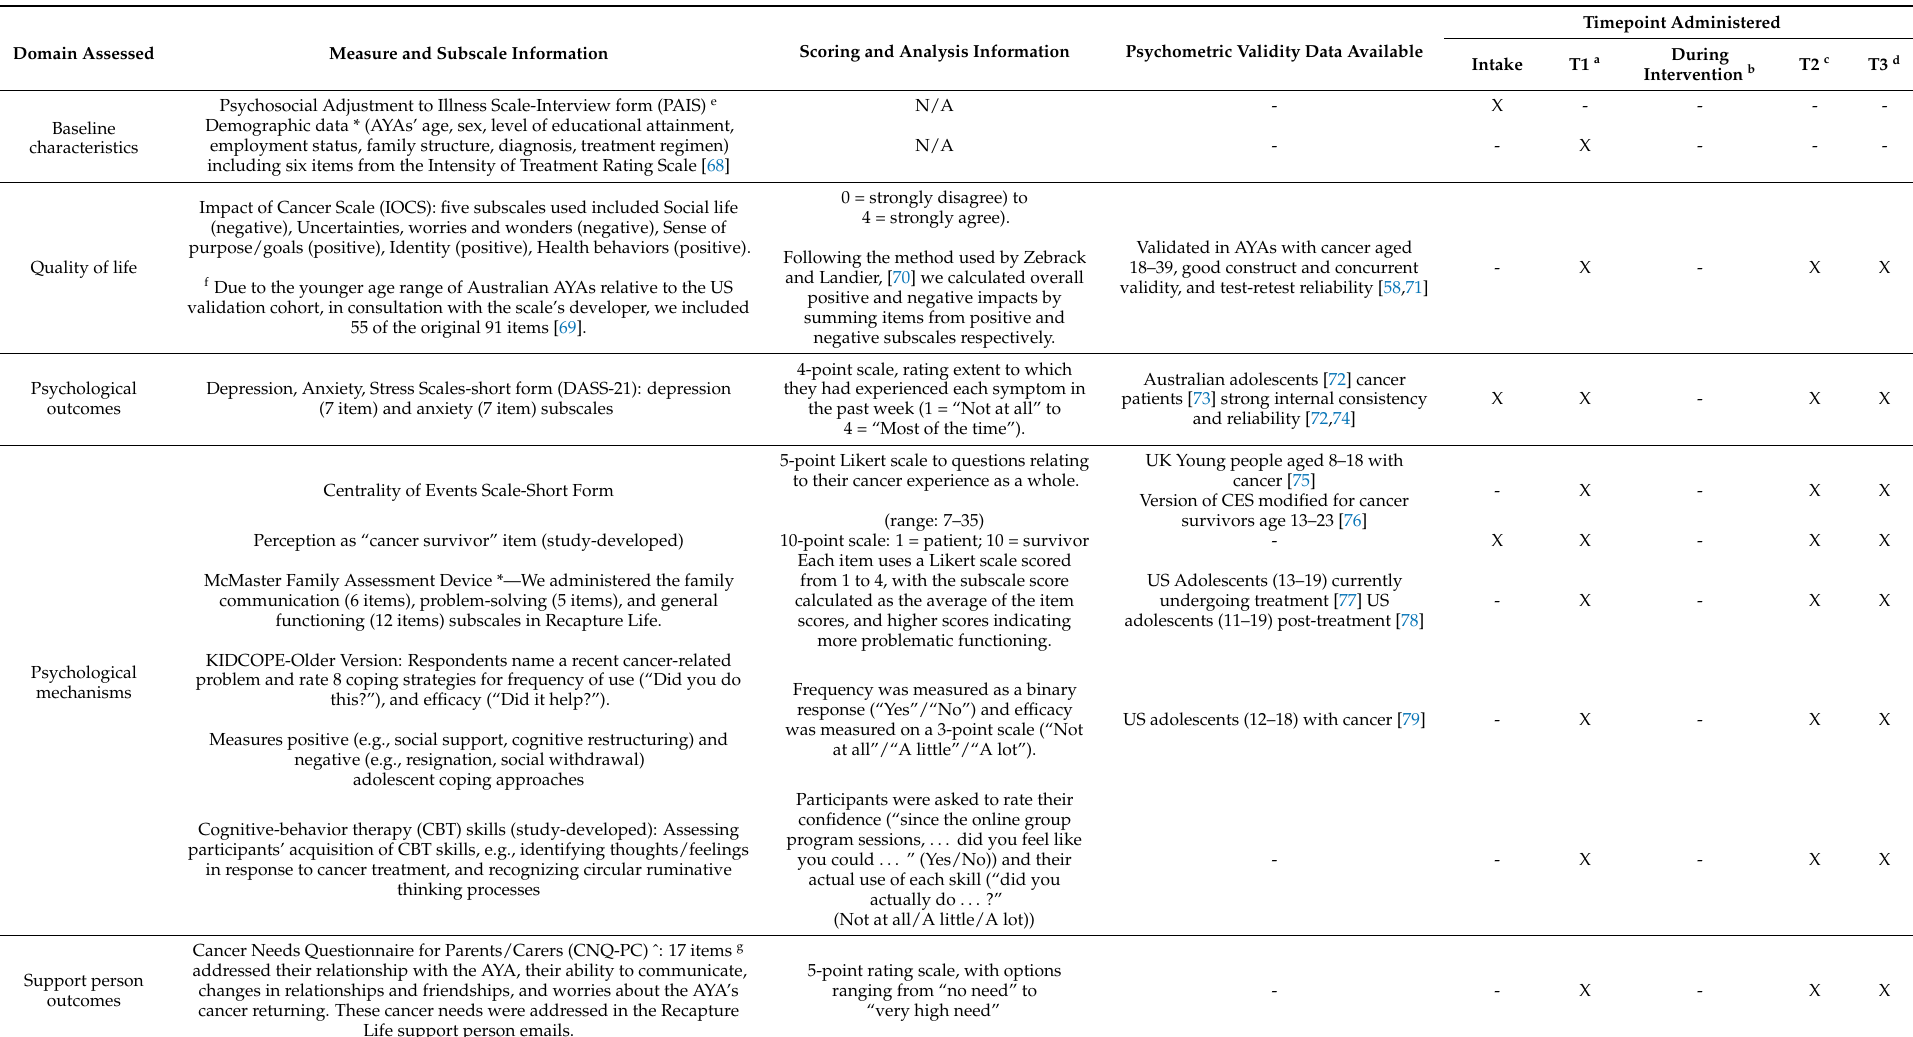
Table 2. Assessment schedule for the Recapture Life